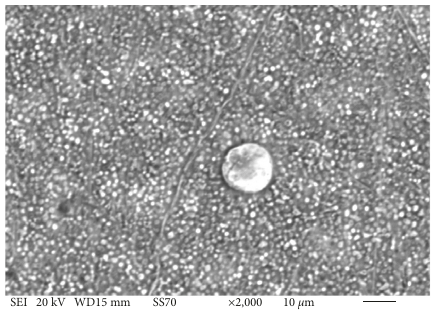
Figure 3: Microstructures of Cu-40 wt.% Pb hypermonotectic alloy under low